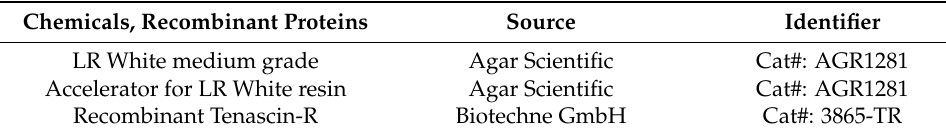
Table 1. Materials used for experiments.